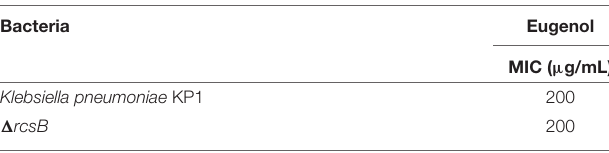
TABLE 3 | Minimum inhibitory concentration (MIC) of eugenol against tested bacteria. Bacteria